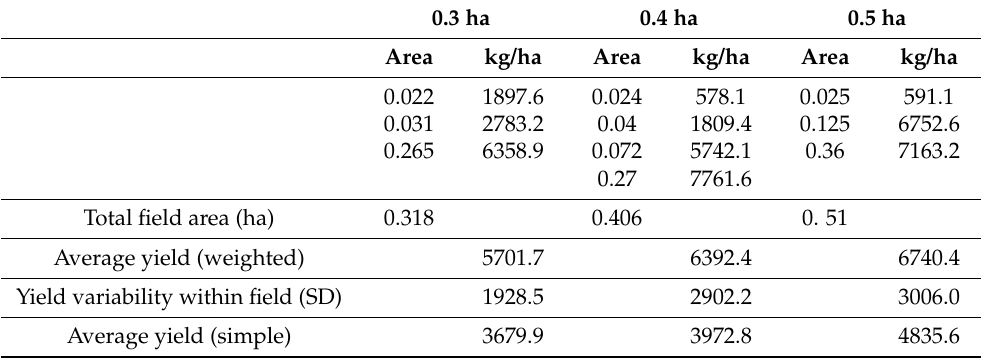
Table 4. Rice grain yield range (kg ha − 1 ) and variability for different fields: 0.3 ha, 0.4 ha and 0.5